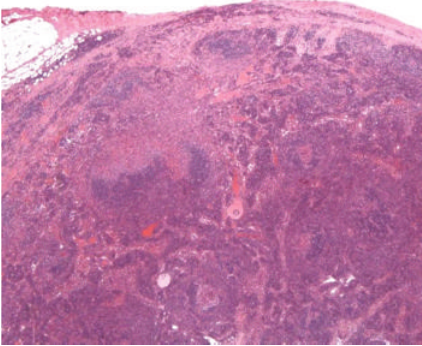
Figure 1: Low power view of Lymph Node with plasma cell variant castleman’s and showing features of Kaposi sarcoma at the top left quadrant.